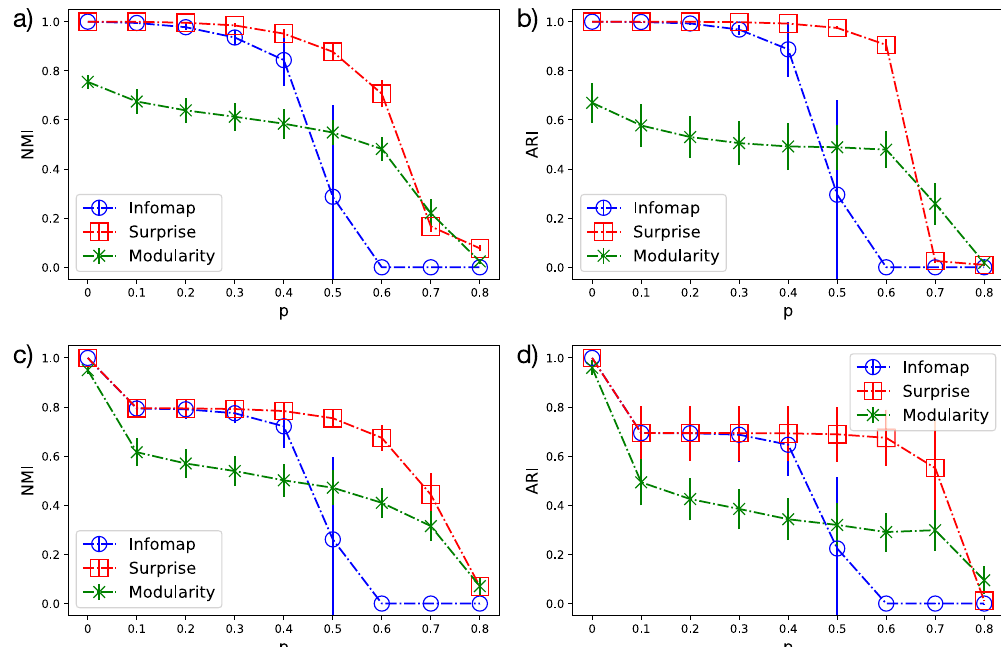
Fig. 5 Comparison of different community detection algorithms on the Relaxed-Caveman (RC) benchmark. Evolution of the Normalized Mutual Information (NMI) and of the Adjusted Rand Index (ARI) on binary undirected ( a , b ) and binary directed ( c , d ) benchmarks. The chosen con fi gurations consist of 512 nodes, grouped in 16 communities arranged in a ring-like fashion and whose size obeys a power-law with exponent 1.8; the smallest community is composed by 3 nodes. The initial con fi gurations are progressively degraded according to the following mechanism: fi rst, a percentage p of links is randomly selected and removed; afterward, a percentage p of links is randomly selected and rewired. For each value of the degradation parameter, one hundred (undirected and directed) networks are generated: the error bars quantify the variability (standard deviation) of the NMI and the ARI values. The trend of the NMI, plotted as a function of the (only) degradation parameter p that drives the evolution of the initial ring of cliques towards a progressively less-de fi ned clustered con fi guration, reveals surprise to outperform both modularity and Infomap. From a more general perspective, these results con fi rm what has been already observed elsewhere, i.e. that the best-performing algorithms on the Lancichinetti – Fortunato – Radicchi (LFR) benchmarks often perform poorly on the Relaxed Caveman (RC) benchmarks and vice